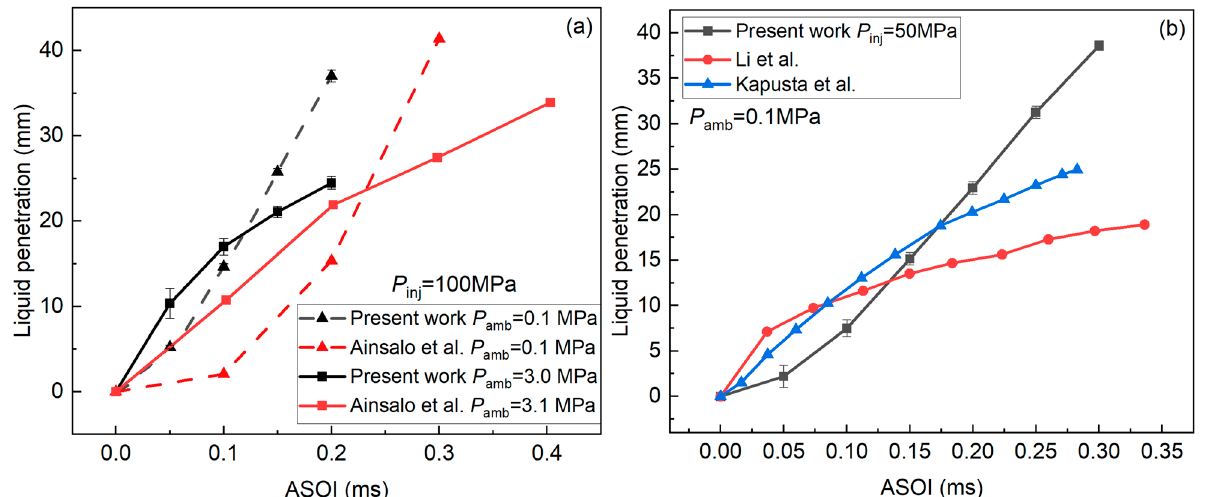
Figure 10. Comparison with the literature: ( a ) Ainsalo et al. [30], P inj = 100 MPa, fuel: liquid propane; ( b ) Li et al. [39], P inj = 30 MPa, fuel: liquid ammonia; Kapusta et al. [48], P inj = 14 MPa, fuel: liquid propane.